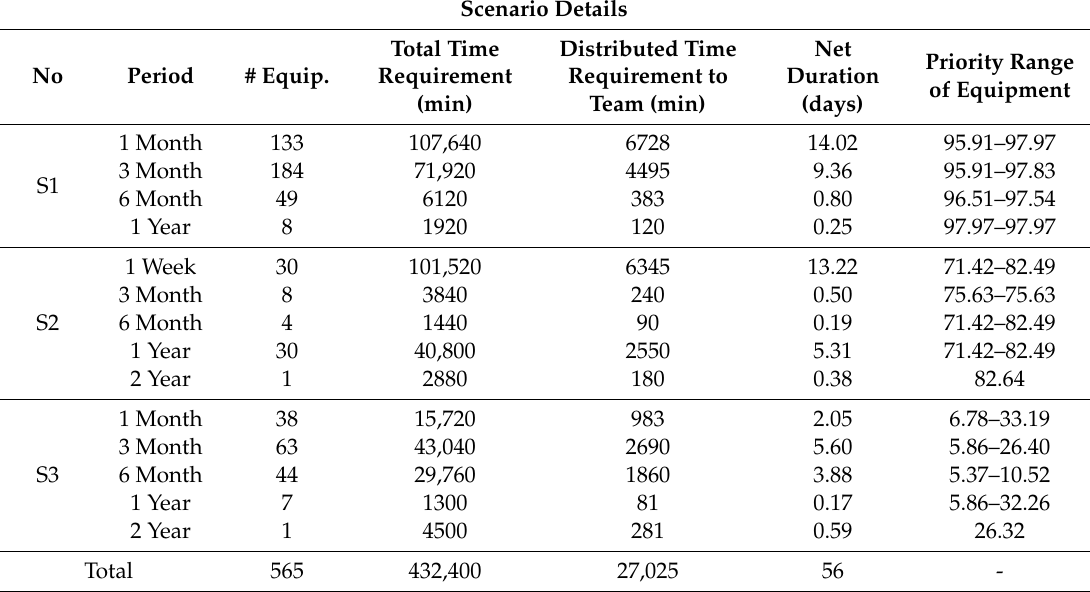
Table 11. Periodic maintenance of mechanical equipment planning scenario